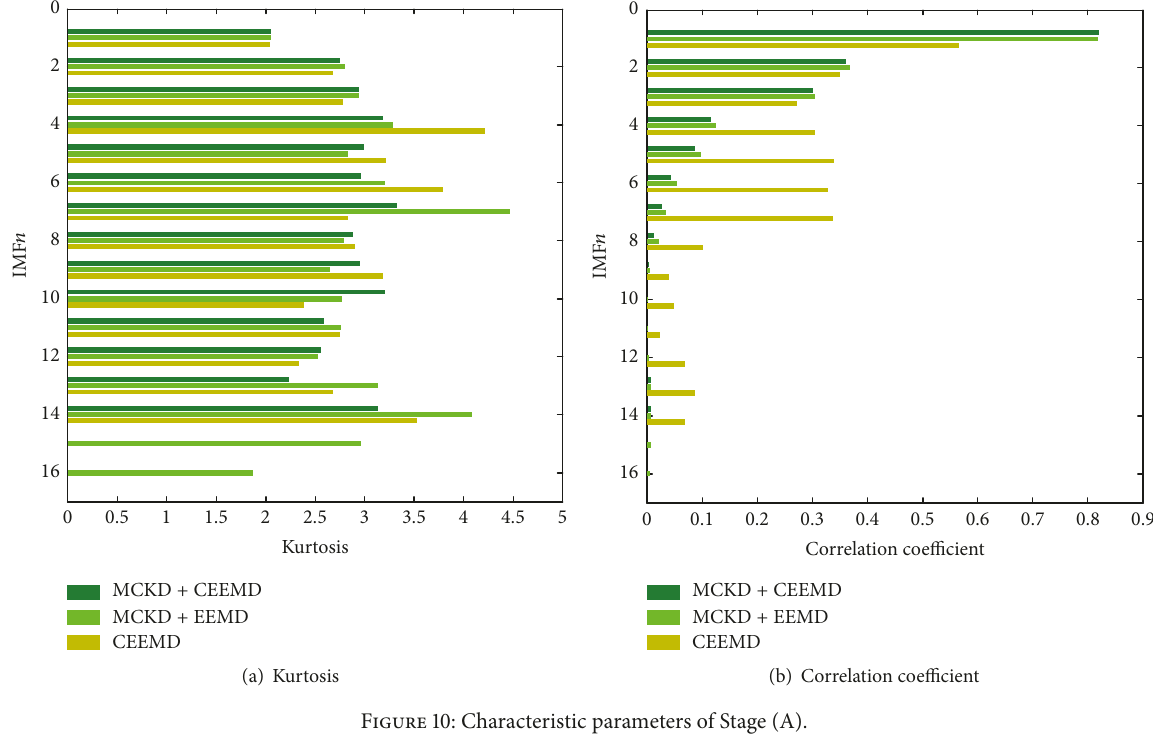
Figure 10: Characteristic parameters of Stage (A).